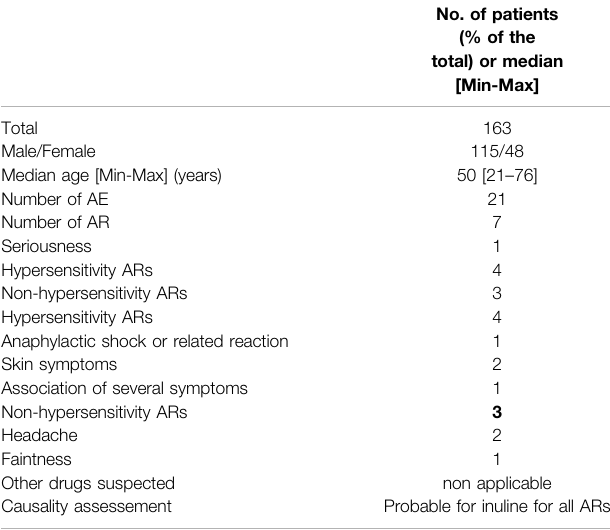
TABLE 2 | Characteristics of ARs in the MultiGFR clinical